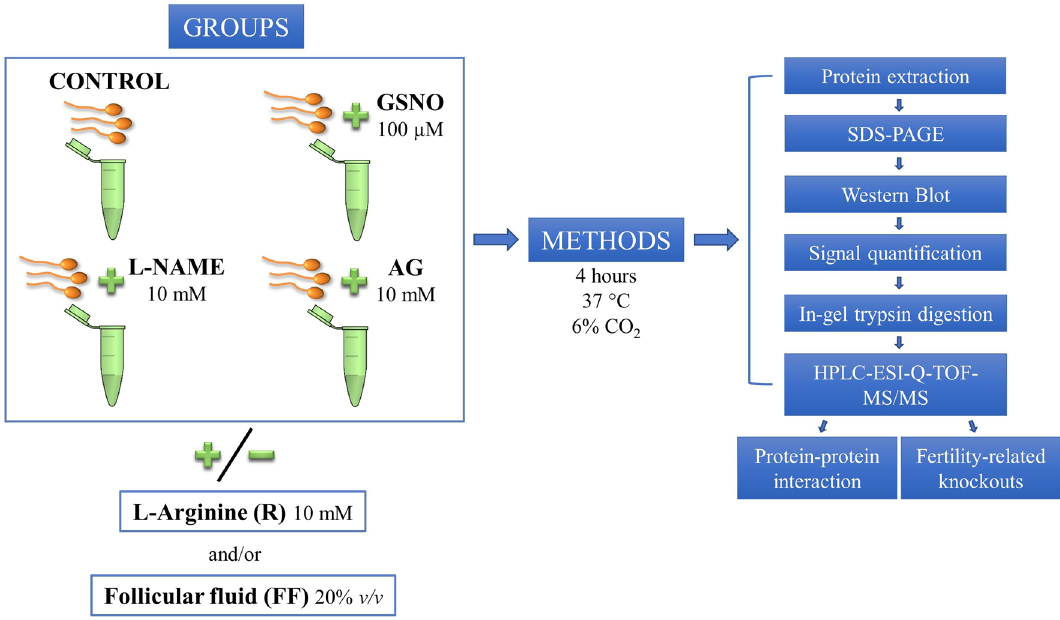
Figure 7. Experimental design. Human spermatozoa were capacitated for 4 h in the presence/absence of a NO donor (GSNO) and two NOS inhibitors (l-NAME and AG). The experimental groups were supplemented or not with L-Arginine and/or follicular fluid (FF). Sperm proteins were subjected to electrophoresis followed by Western Blot to analyze the phosphorylation levels of phospho-PKA substrates (PKAs-P) and tyrosine residues (Tyr-P). The amount of signal in each membrane was determined by chemiluminescence and, subsequently, quantified. Specific protein bands, that showed significant differences amongst the treatments mentioned